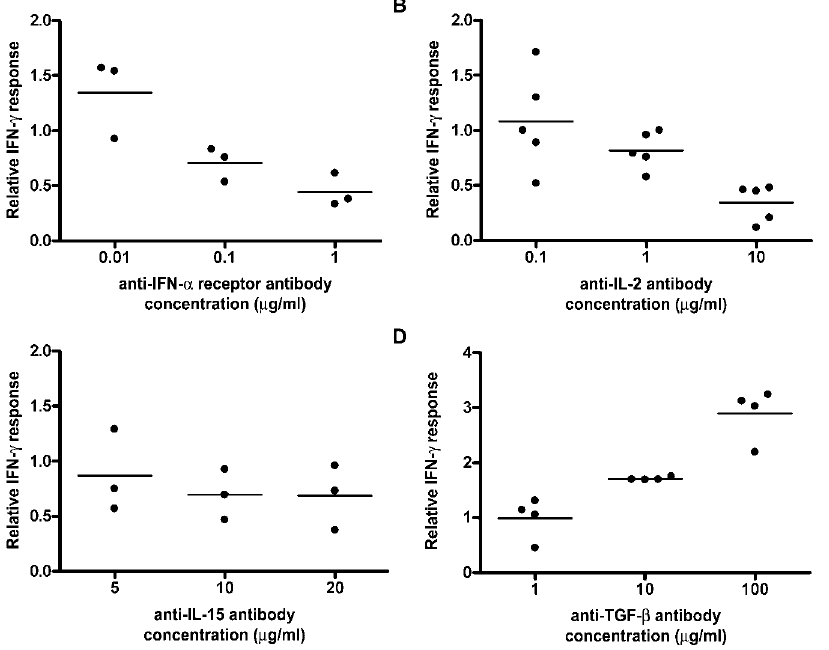
Figure 5. The NK Cell Response to iRBCs Is Controlled by Type 1 IFN, IL-2, and TGF- b PBMCs from malaria-naı¨ve donors were stimulated for 24 h with iRBCs in the presence of increasing concentrations of neutralising antibodies to (A) the IFN- a / b receptor, (B) IL-2 , (C) IL-15, or (D) TGF- b . Percentages of IFN- c NK cells relative to those observed with the respective concentration of isotype- matched control antibodies are shown. Only donors known to make a strong IFN- c response to iRBCs were used; baseline percentages of NK cells that were IFN- c þ after iRBC stimulation ranged from 5% to 40% for the donors shown